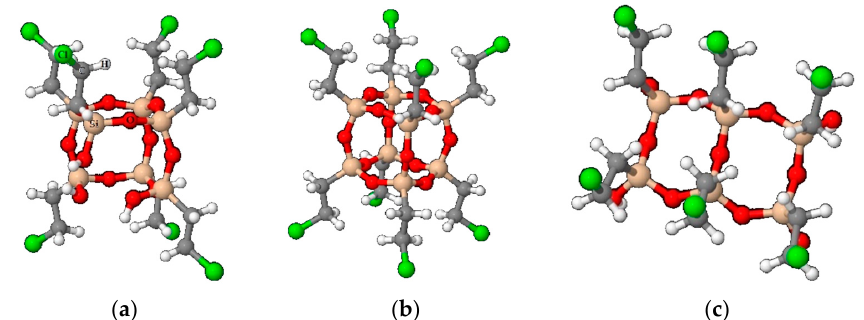
Figure 3. Ordered structures in the silica matrix built by (SiO) 4 rings in ClETEOS as an example: ( a ) open cage (T 7 ), ( b ) cage (T 8 ), and ( c ) short ladders. ( a ) open cage (T 7 ), ( b ) cage (T 8 ), and ( c ) short